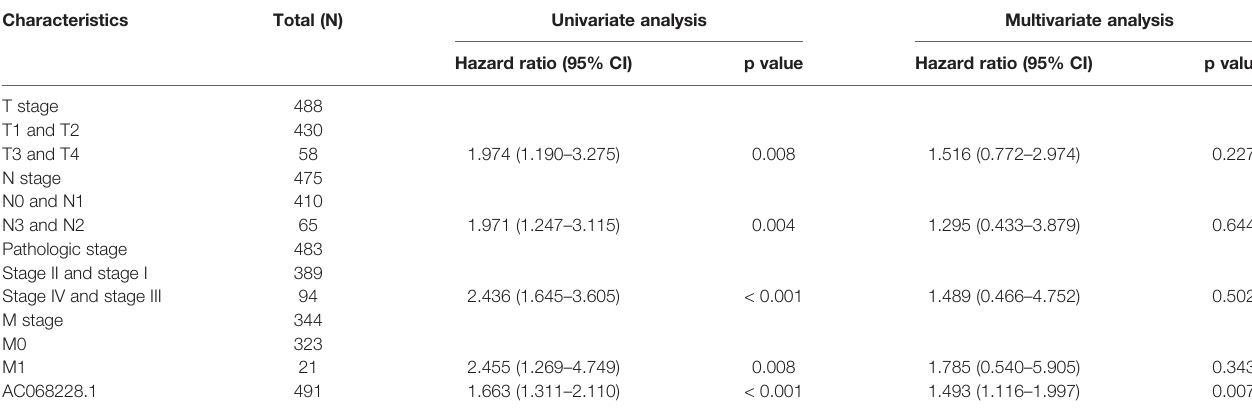
TABLE 2 | Univariate and multivariate Cox regression analyses of different parameters on disease-speci fi c survival in lung adenocarcinoma. Characteristics